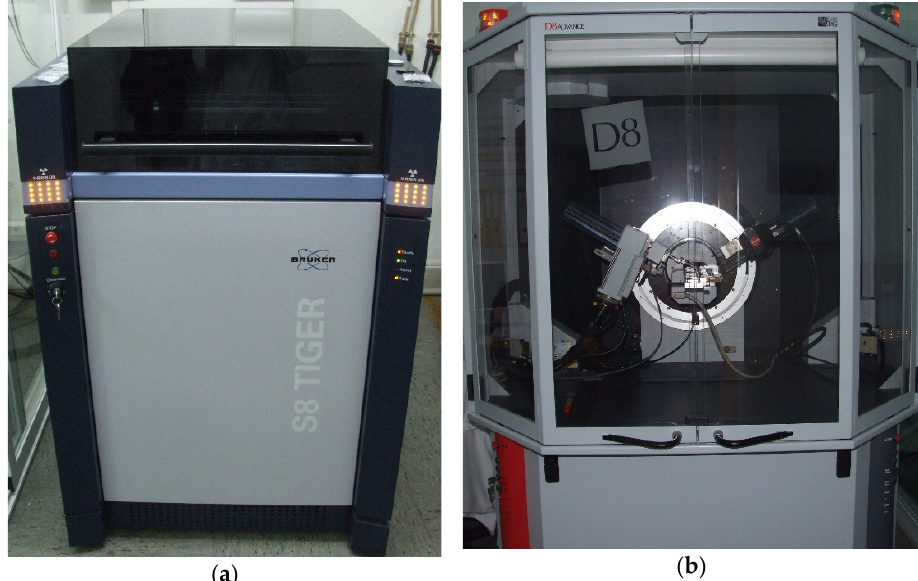
Figure 4. Instrumental techniques to determinate chemical and mineralogical composition of cement by XRF ( a ) and XRD methods ( b ).